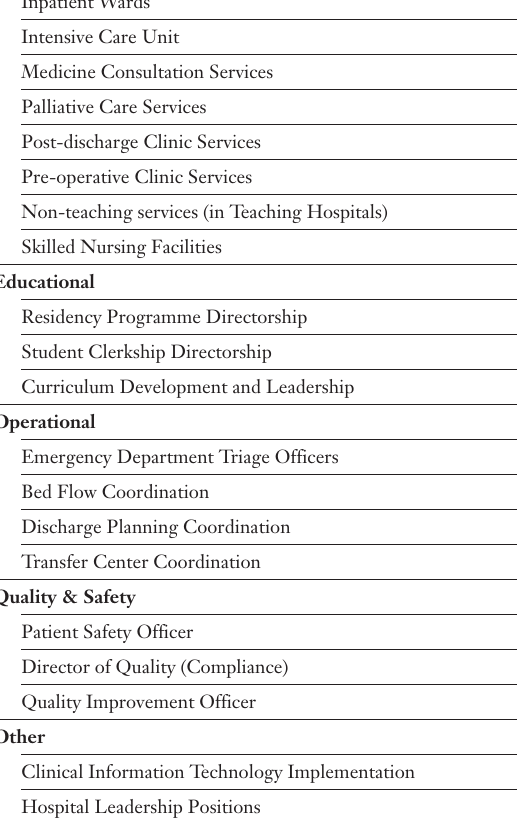
Potential roles for